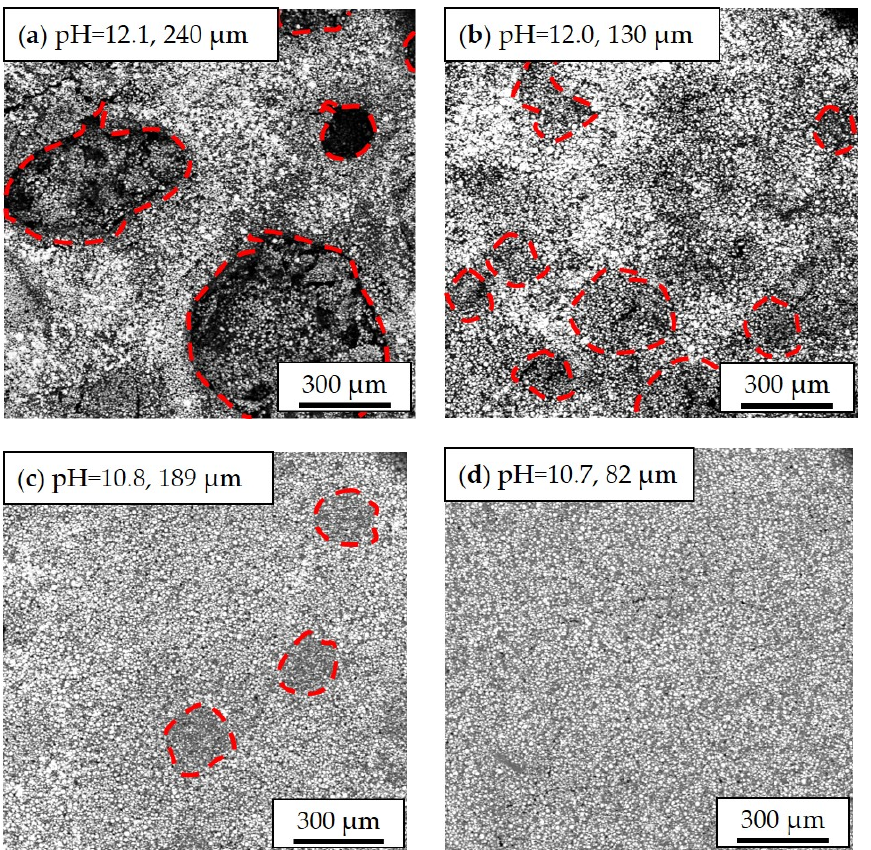
Figure 4. Scanning electron microscope (SEM) images of cathode films with different slurry pH values and different thicknesses: ( a ) pH = 12.1, 240 µm; ( b ) pH = 12.0, 130 µm; ( c ) pH = 10.8, 189 µm; ( d ) pH = 10.7, 82 µm. The craters on the electrode surface with different diameters are marked with red dot lines.